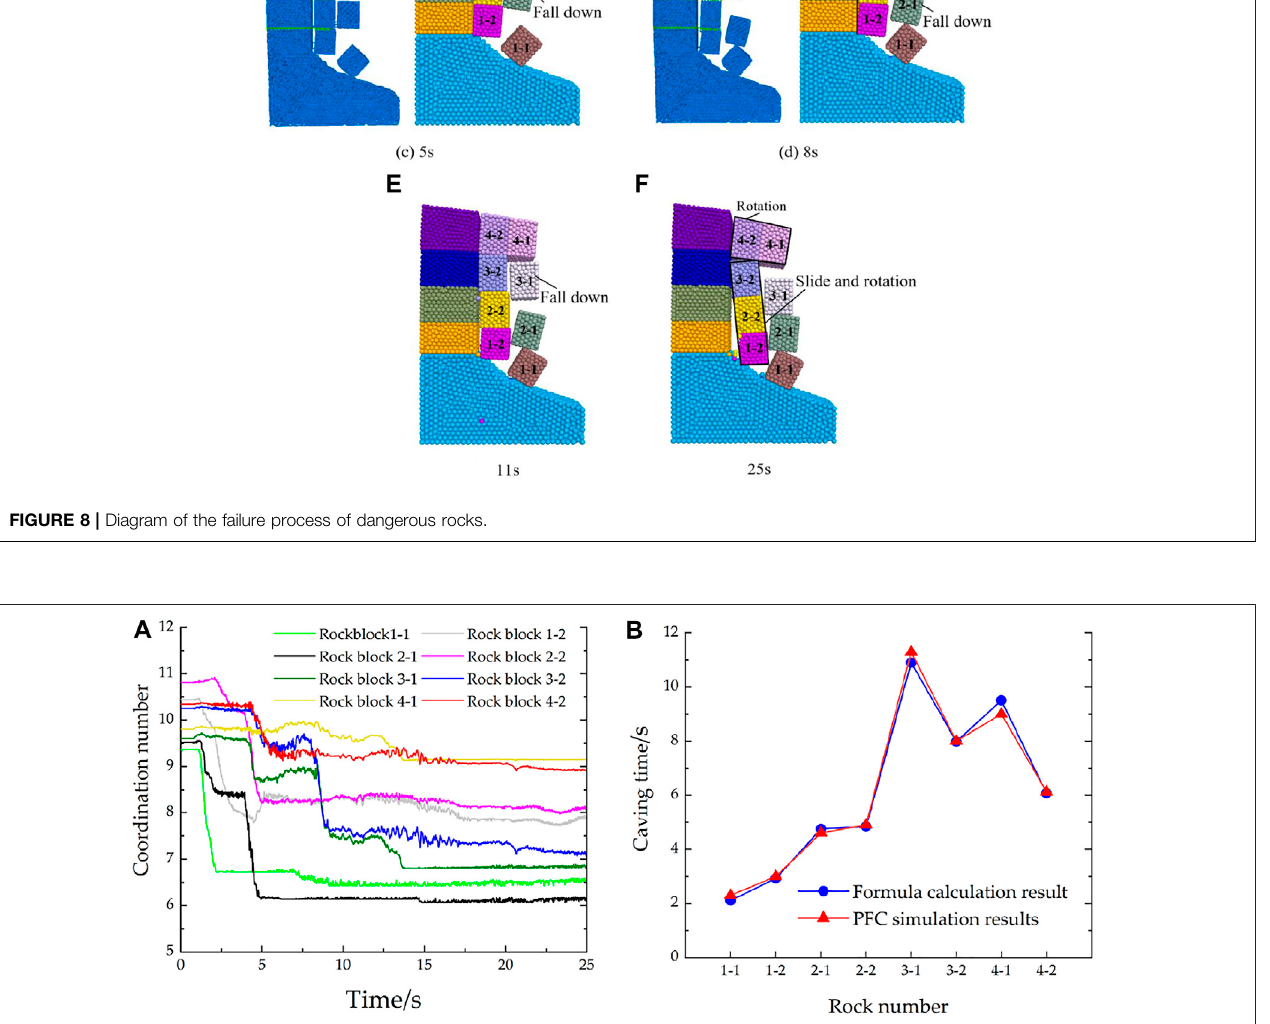
Frontiers in Earth Science |